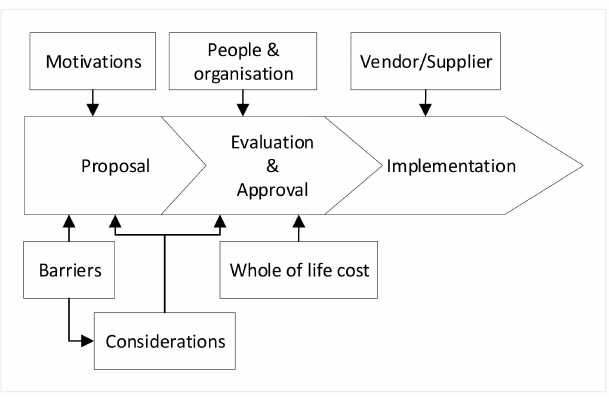
Figure 12. The core structure and categories of factors in the proposed governance